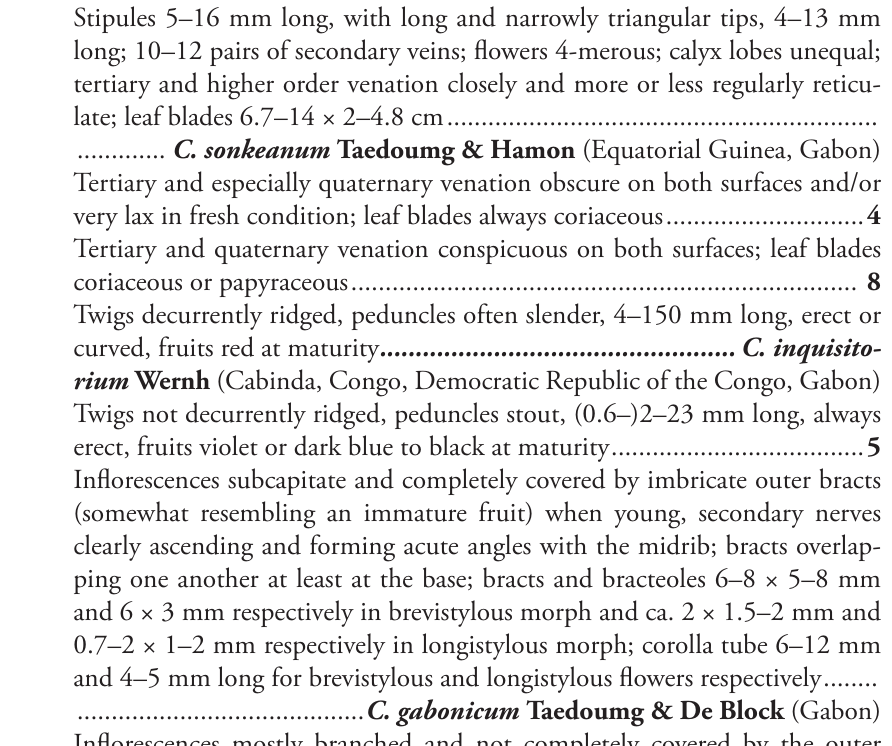
Stipules 5–16 mm long, with long and narrowly triangular tips, 4–13 mm long; 10–12 pairs of secondary veins; flowers 4-merous; calyx lobes unequal; tertiary and higher order venation closely and more or less regularly reticu-